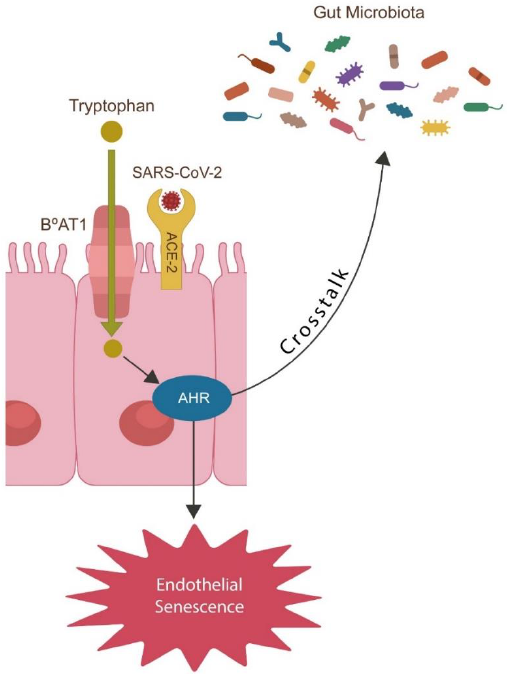
Figure 4. In the GI tract, ACE-2 dimerizes with the neutral amino acid transporter B0AT1 involved in Trp absorption. Trp, an Ahr ligand, coordinates host–microbiota interaction and local metabolism. Dysfunctional Trp absorption and defective Ahr may contribute to barrier disruption and microbial translocation into the systemic circulation. Legend: Trp, tryptophan, B0AT1, neutral amino acid transporter, AHR, aryl hydrocarbon receptor.